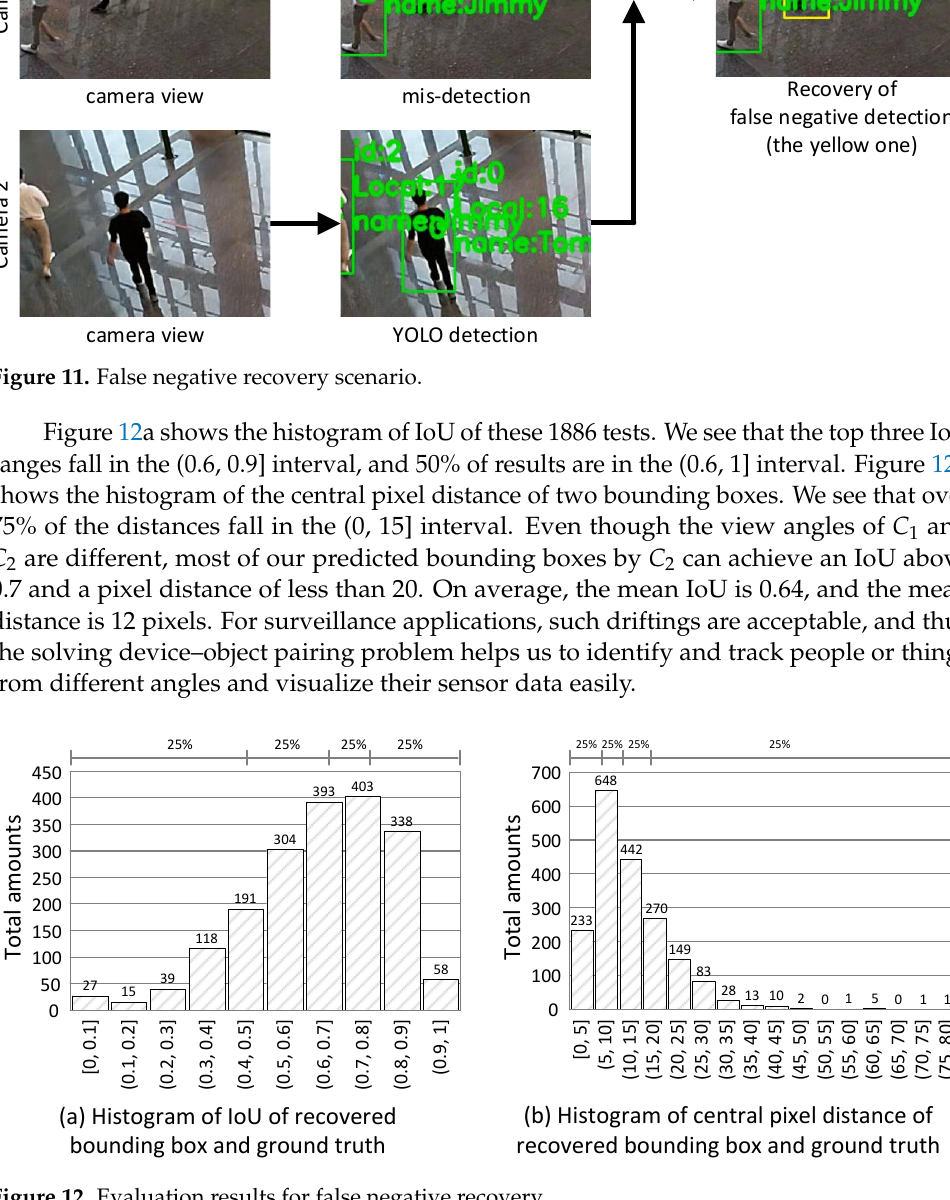
Figure 12. Evaluation results for false negative